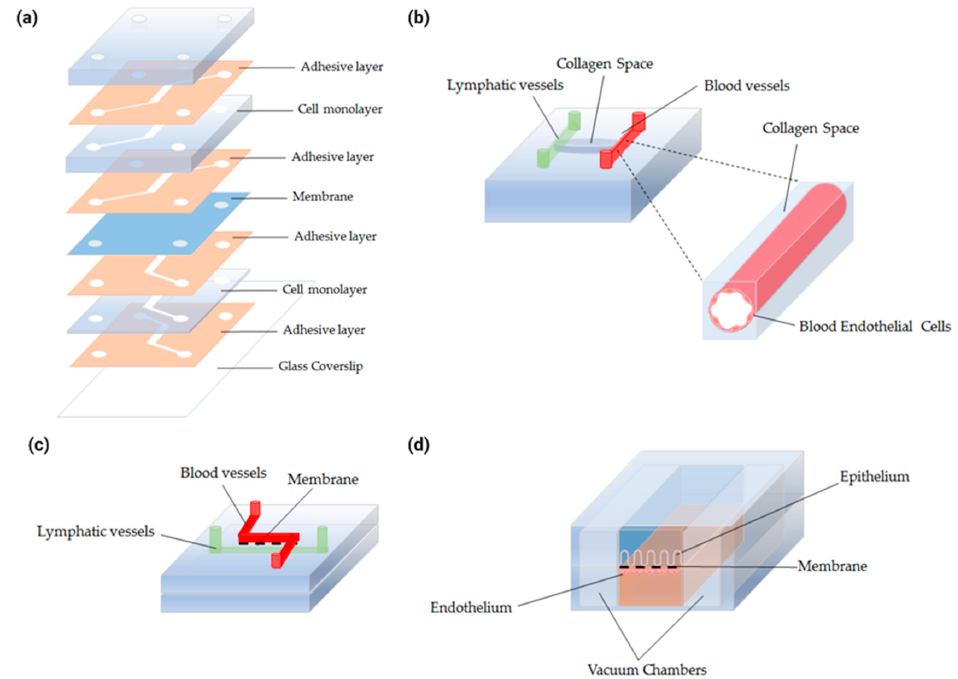
Figure 5. Microfluidic chip designs for a potential intestinal-vasculature-on-a-chip: ( a ) The “cut and assemble” method can be used to independently design the channel of each layer [132], ( b ) the 3D cylindrical system can be used for more physiologically relevant model of the intestinal vasculatures for 3D analyses [133], ( c ) blood and lymphatic vessels can be formed on a single chip [134], and ( d ) vacuum chambers generate cyclic mechanical strain [124].